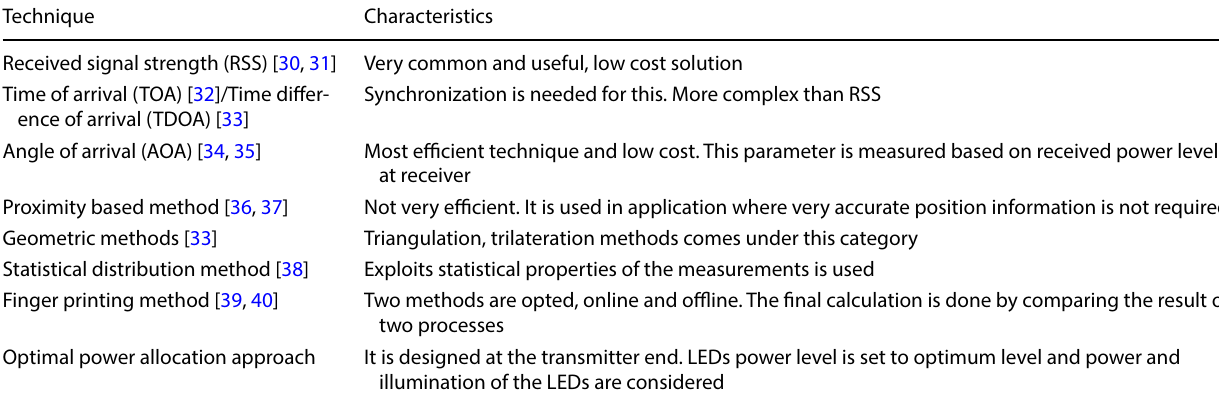
Table 5 Different techniques used in VLC system Technique